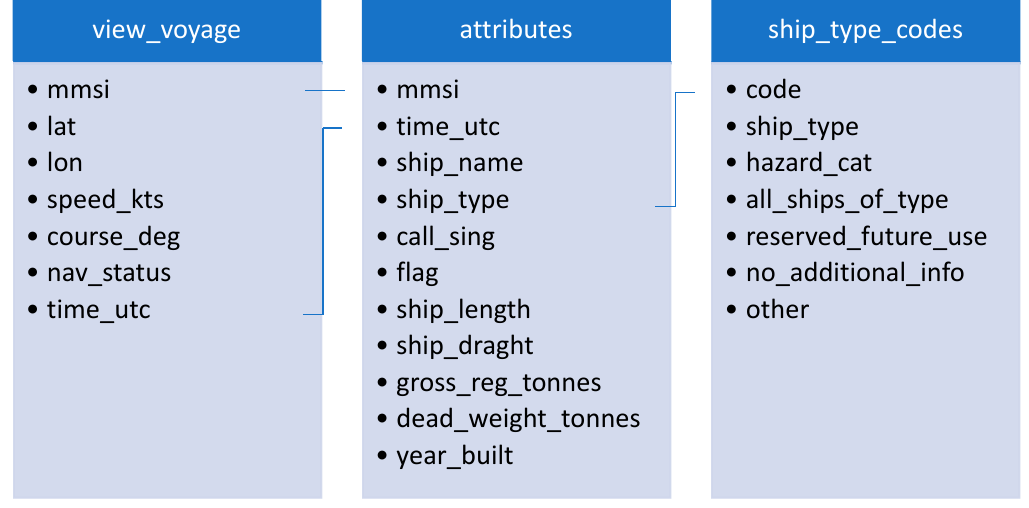
Figure 7. Database Figure 7. Database Schema.